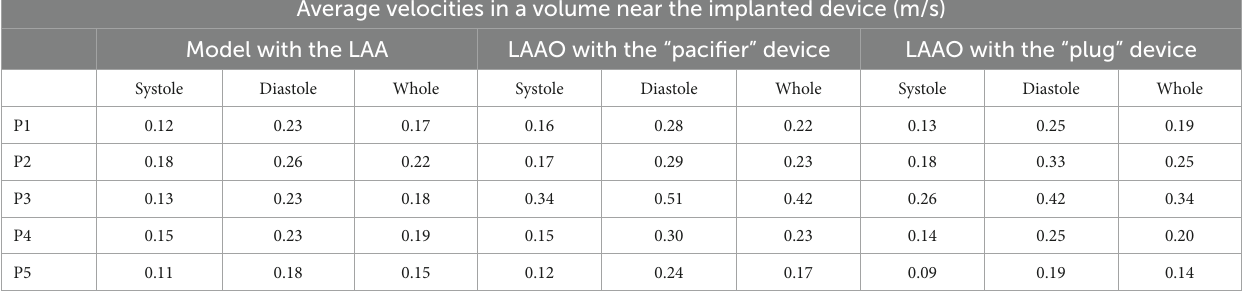
TABLE 2 Average velocities in a volume near the implanted device in the simulations performed in the five patients enrolled in the study. Average velocities in a volume near the implanted device (m/s)